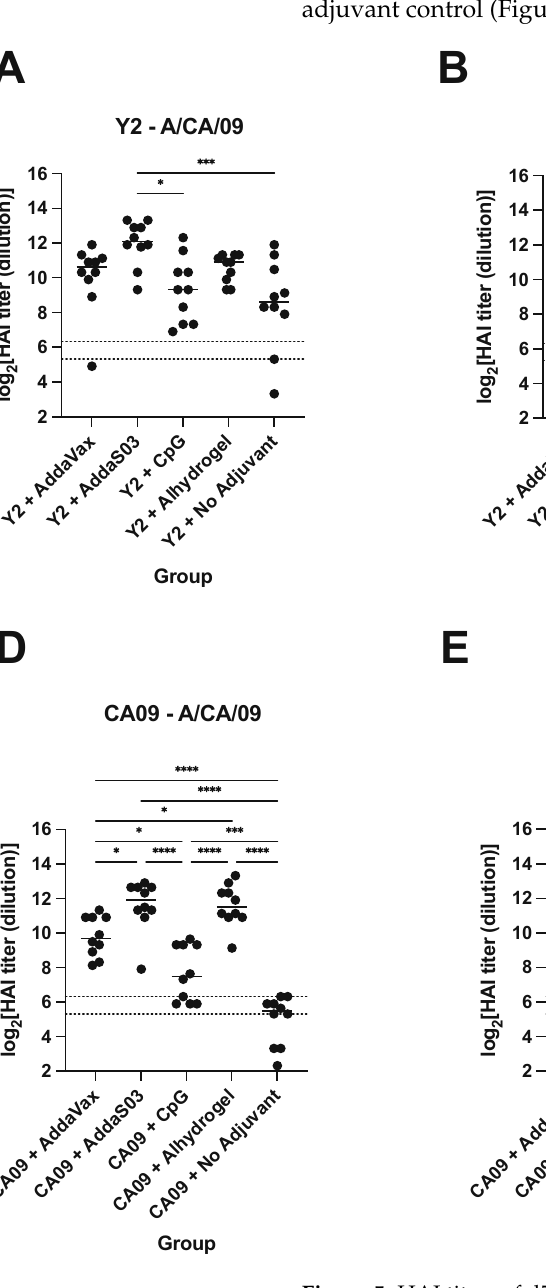
Figure 5. HAI titers of d56 sera from Y2- and CA09 HA-immunized mice. HAI titers against a panel of recent H1N1 viruses are shown for ( A – C ) Y2- and ( D – F ) CA09 HA-immunized animals. Titers are represented as log 2 -transformed reciprocal dilutions. The lower dotted line represents a titer of 1:40 and the upper line a titer of 1:80, which we defined as the threshold for seroprotection in this study. A/CA/09, A/California/07/2009; A/BR/18, A/Brisbane/02/2018; A/GM/19, A/Guangdong- Maonan/SWL1536/2019. *, p ≤ 0.05; **, p ≤ 0.01; ***, p ≤ 0.001; ****, p ≤